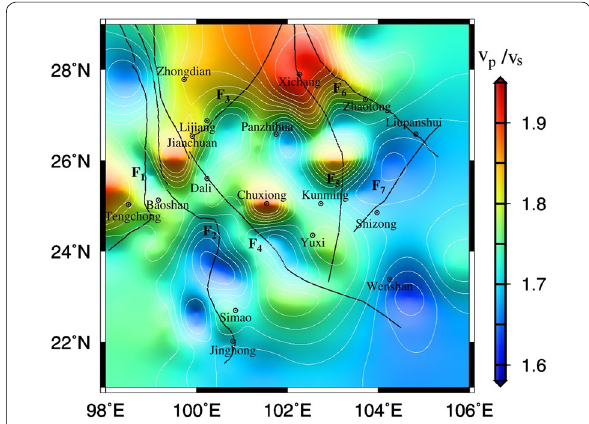
Fig. 10 Distribution of the crustal wave velocity ratio in the research